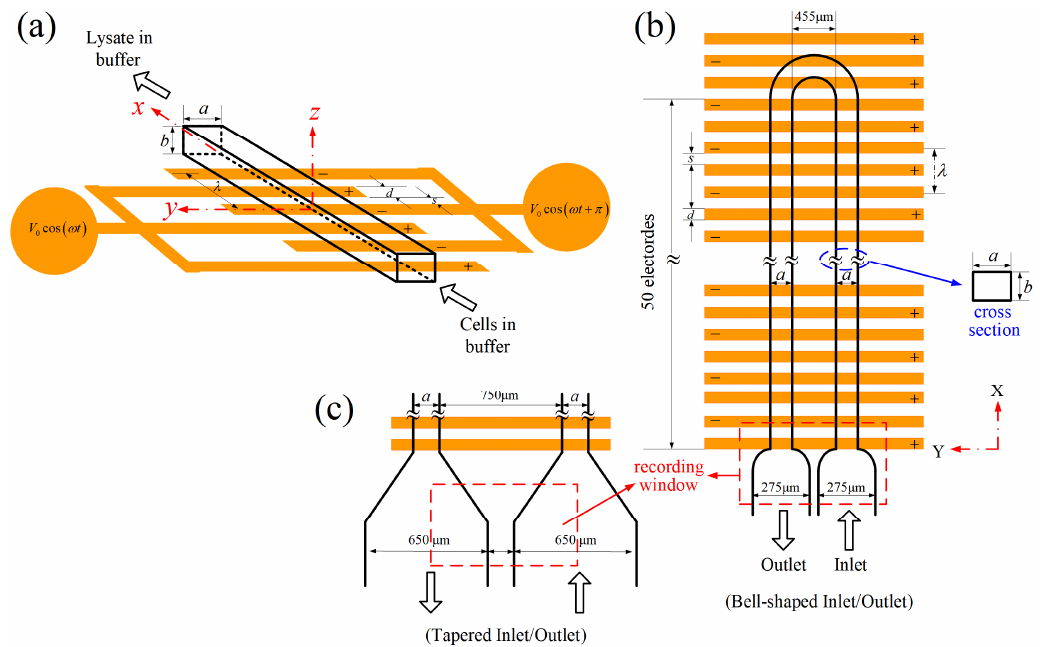
Figure 1. ( a ) Sketch of a simple flow-through device for continuous electrical lysis of cells. ( b ) Top view of the device employed in the present study. The flow phenomenon of cells at the inlet and outlet can be observed and recorded simultaneously in this experimental design. ( c ) An alternative inlet / outlet design for reducing the flow in comparison with that in ( b ), for a clear observation of cell lysis. The device was fabricated via standard microelectromechanical system (MEMS) techniques, including photolithography, wet etching, and molding using polydimethylsiloxane (PDMS), similar to those in fabricating a traveling wave dielectrophoretic pump for blood delivery [25]. The electrode array was fabricated with gold (100 nm in thickness) on a glass substrate. A chrome layer (30 nm)